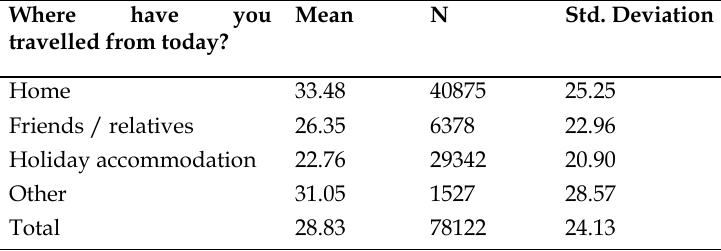
Table 8. How far have you travelled to get to this property?